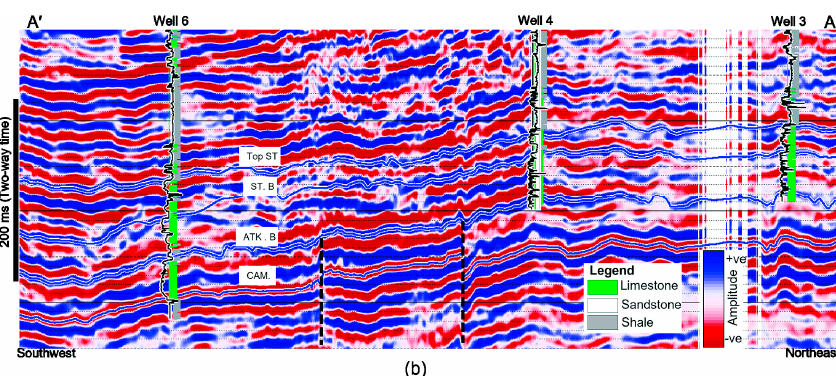
Figure 7. ( a ) Structure time map at top Strawn showing axis of three valleys (dashed white arrows). Dashed yellow line = shelf edge. Double-headed yellow arrow = width of northeast-southwest- trending valley. ( b ) Cross section A–A ′ through three wells 3, 4, and 6 showing interpreted horizons. Note: two vertical dashed-black lines = vertical faults, black curve = gamma-ray log, and inserted litholog = limestone (green), sandstone (white), and shale (gray) composition. Top ST—top Strawn, ST. B—Strawn B, ATK. B—Atoka Base, and CAM.—Cambrian. White dashed arrows in ( a ) indicate valley axes. Numbers (in white) in ( a ) indicate well names. Yellow double-headed arrow indicates width of northernmost valley.